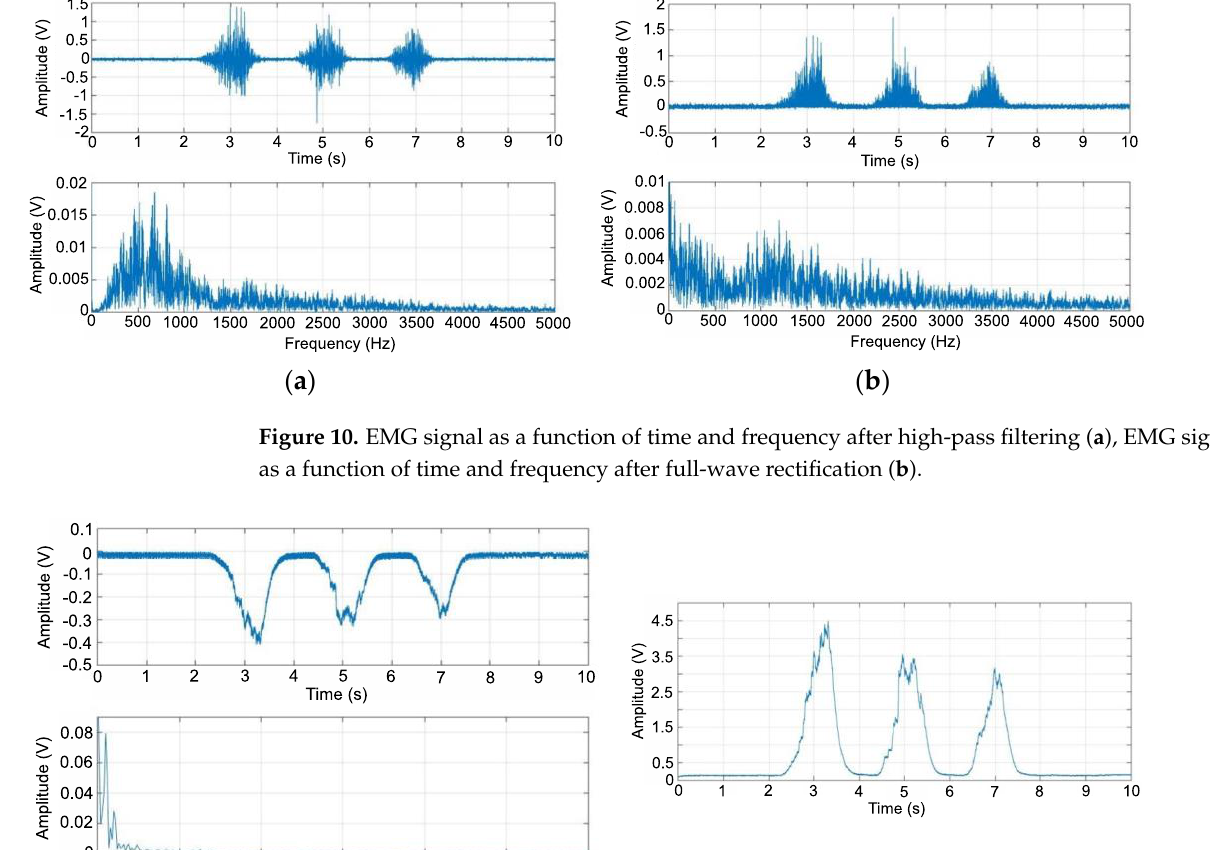
Figure 10. EMG signal as a function of time and frequency after high-pass filtering ( a ), EMG signal as a function of time and frequency after full-wave rectification ( b ).